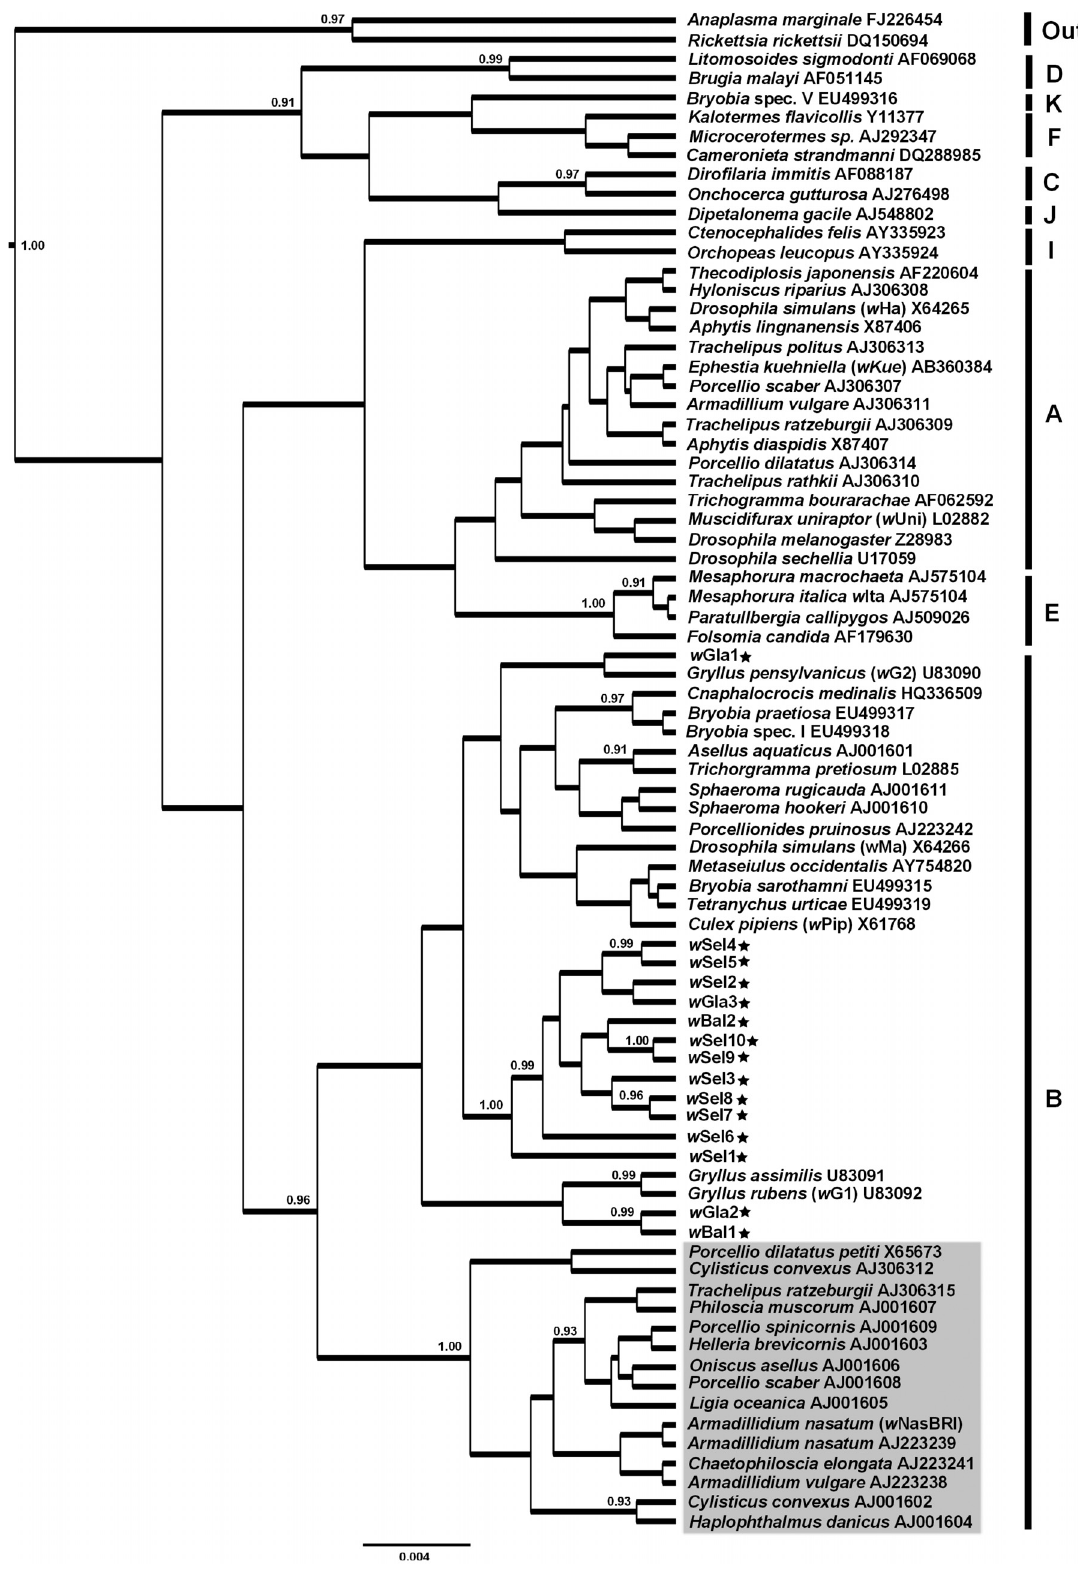
Figure 2 - Bayesian tree constructed based on partial 16S rDNA sequences of Wolbachia from Balloniscus species (denoted with stars) and another 16S rDNA from Wolbachia supergroups. Bayesian PCP values are shown (only those above 0.90). Names the host arthropod species followed by Wolbachia strain name and an accession number denotes the specific Wolbachia strain. Letters A-F denote Wolbachia supergroups; out: outgroup. Grey square: Oni